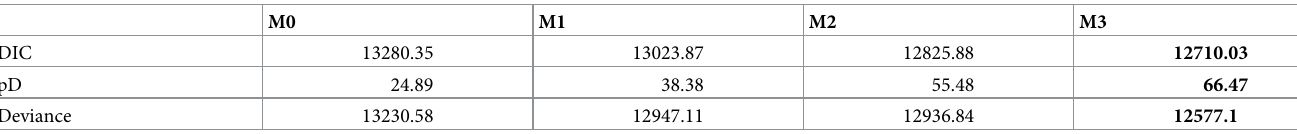
Table 3. Model’s goodness of fit comparison and selection based on DIC, pD and deviance. M0